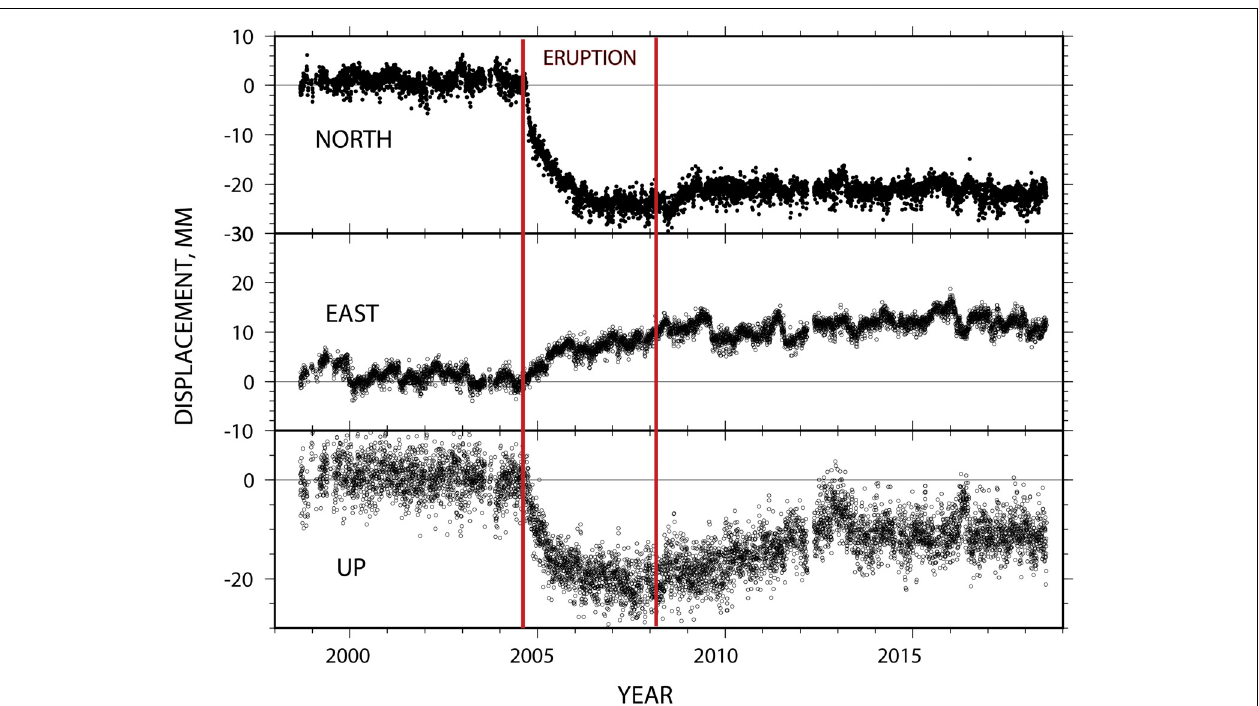
FIGURE 5 | Time series plot showing North, East, and Up displacements at CGPS station JRO1, 1998–July 2018. Background deformation rates of 5.78 mm/yr North, 3.42 mm/yr East, and –0.5 mm/yr Up have been removed, along with seasonal effects. Slow-slip events along the Cascadia subduction zone affect mostly the East component, where they appear as a variable-amplitude signal with a period of ∼ 14